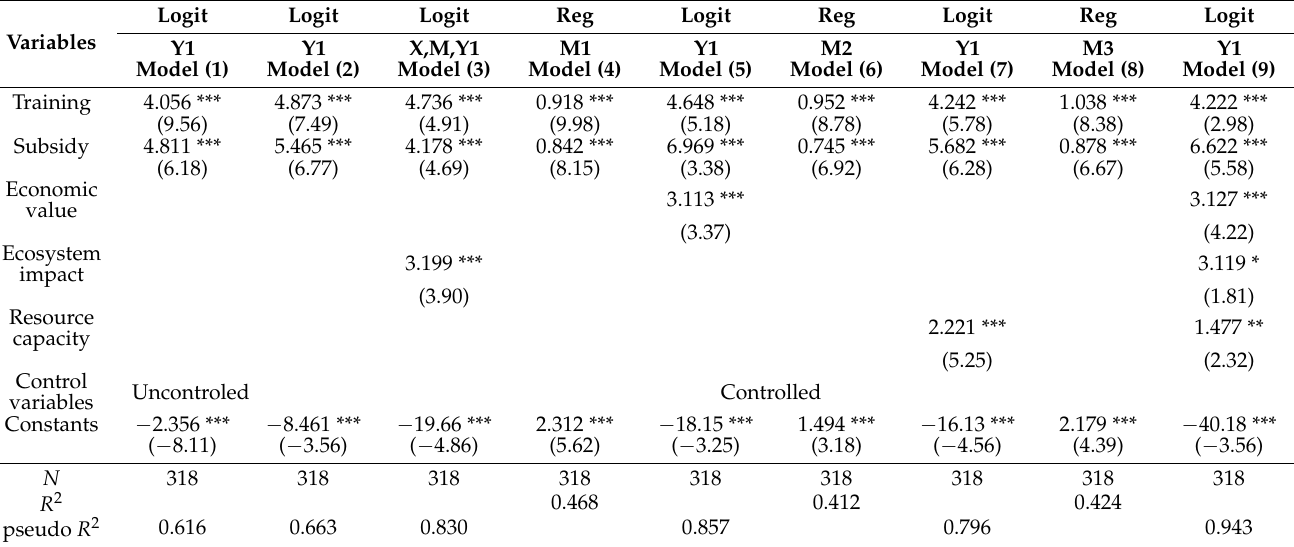
Table 3. The mediating effect of farmers’